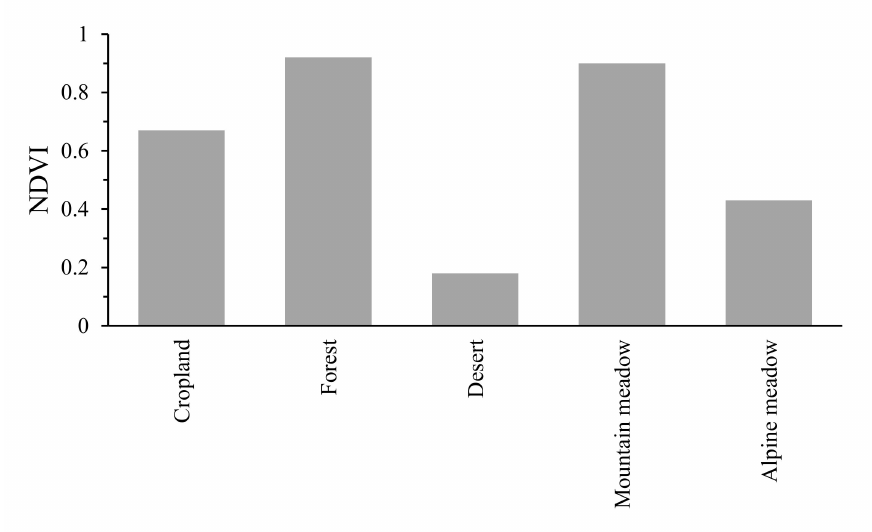
Figure 6. Average NDVI value for main vegetation types during 2000–2017 in Altay